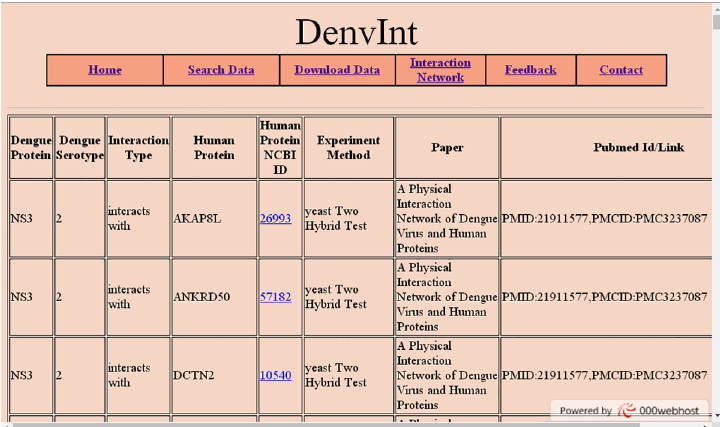
Fig 3. Screenshot of user query interface of DenvInt database. User choosesdengueprotein NS3 and all PPI with human proteins; and dengueserotype, interaction type, NCBI ID, paper title, and PMID are retrieved and presented in the web page. NCBI ID, NationalCenter for Biotechnology Information ID; PMID, PubMed ID; PPI, protein–protein